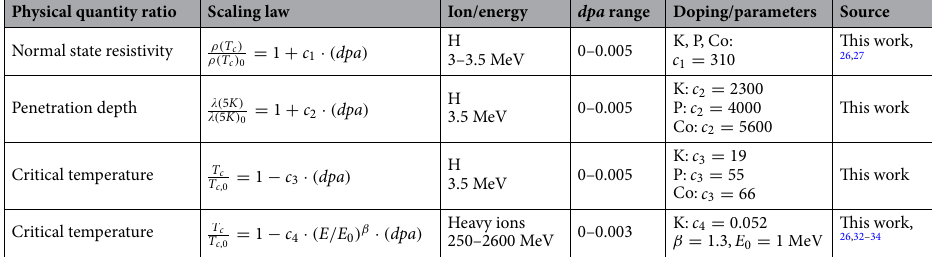
Table 1. The table summarizes the scaling laws discussed throughout the paper. Each of them deals with the physical quantity listed in the first column, and is reported in the second column as the ratio between the quantity for the irradiated samples and the value for the pristine material (indicated by the subscript 0). These ratios are expressed as a function of disorder ( dpa , displacements per atom) and ion energy ( E , MeV). In the third column the used ions and energies are listed, and in the forth one the investigated range of dpa is reported. c i , with i = 1, 2, 3, 4 , and β are fitting parameters, whose values are reported in the fifth column for each compound (K= Ba 1 − x K x Fe 2 As 2 , P= BaFe 2 As 1 − x P x ) 2 , and Co=Ba( Fe 1 − x Co x ) 2 As 2 ). Finally, the last column shows the sources of the data used to deduce the reported scaling laws.